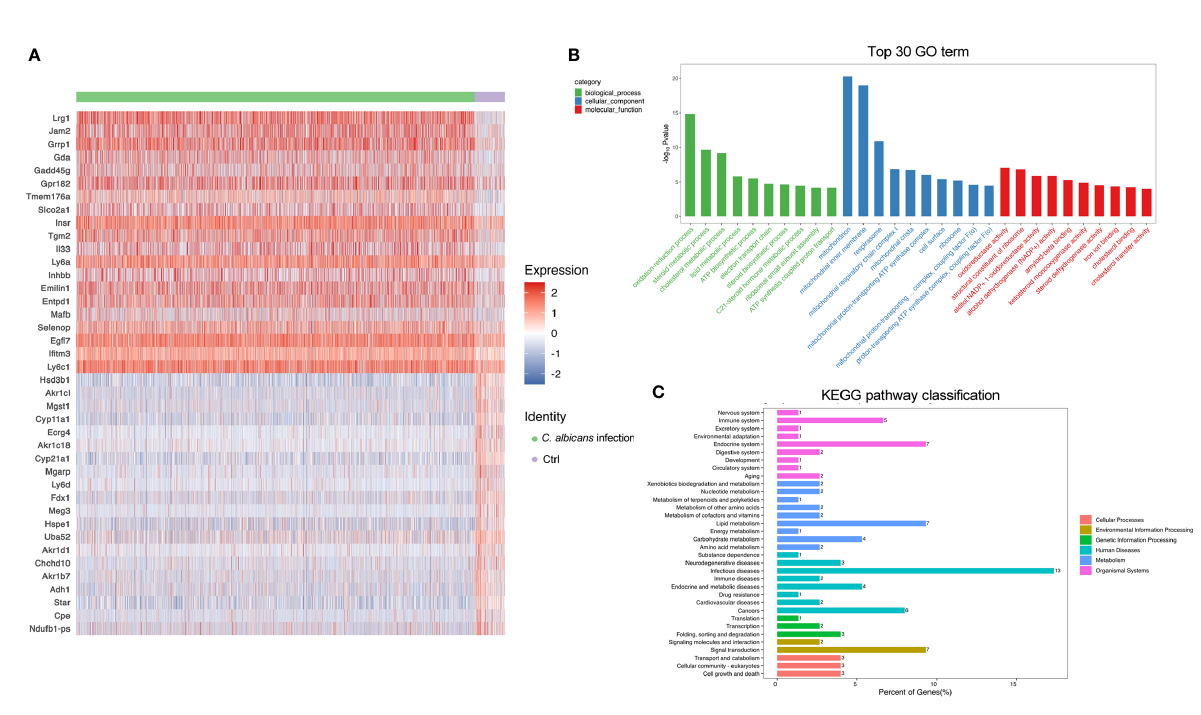
FIGURE 4 DEGs in endothelial cells following systemic C. albicans . (A) Heatmap of the top 20 DEGs between the infected and uninfected groups. (B) GO and (C) KEGG enrichment analyses of the